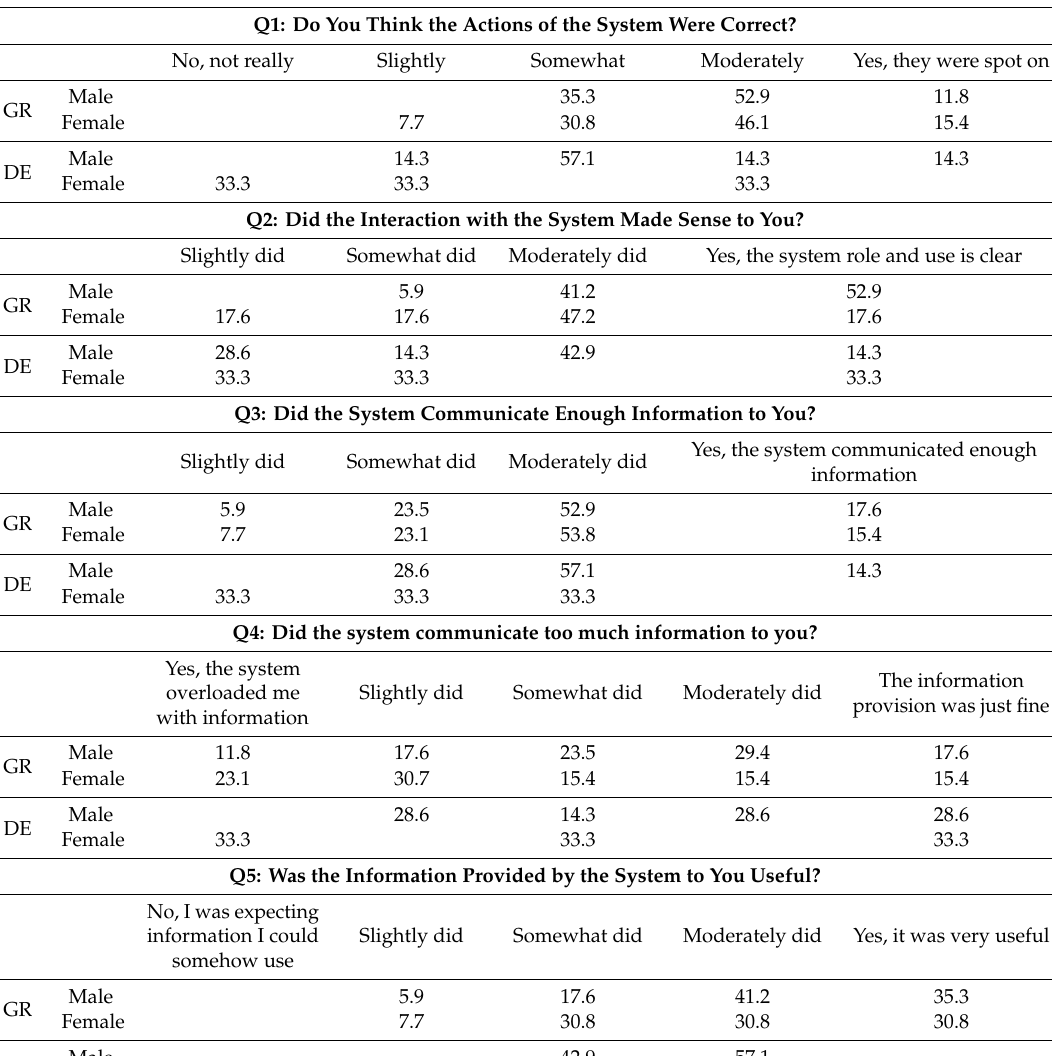
Table A2. Distribution (%) of Greek (N = 30, 17 male, 13 female) and German (N = 10, 7 male, 3 female) users’ responses in the usability evaluation questions postinteraction per gender. The origin of the participants is depicted using the abbreviations GR for Greek and DE for German